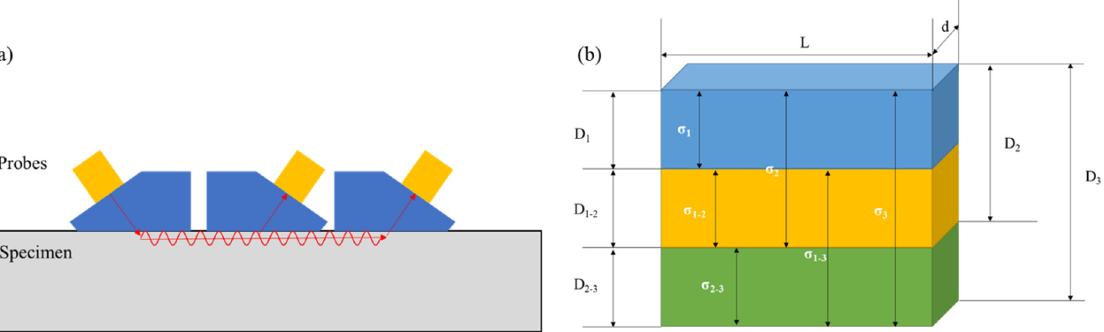
Figure 8. Schematics for ( a ) pitch-catch experimental configuration and ( b ) residual stress gradient model.